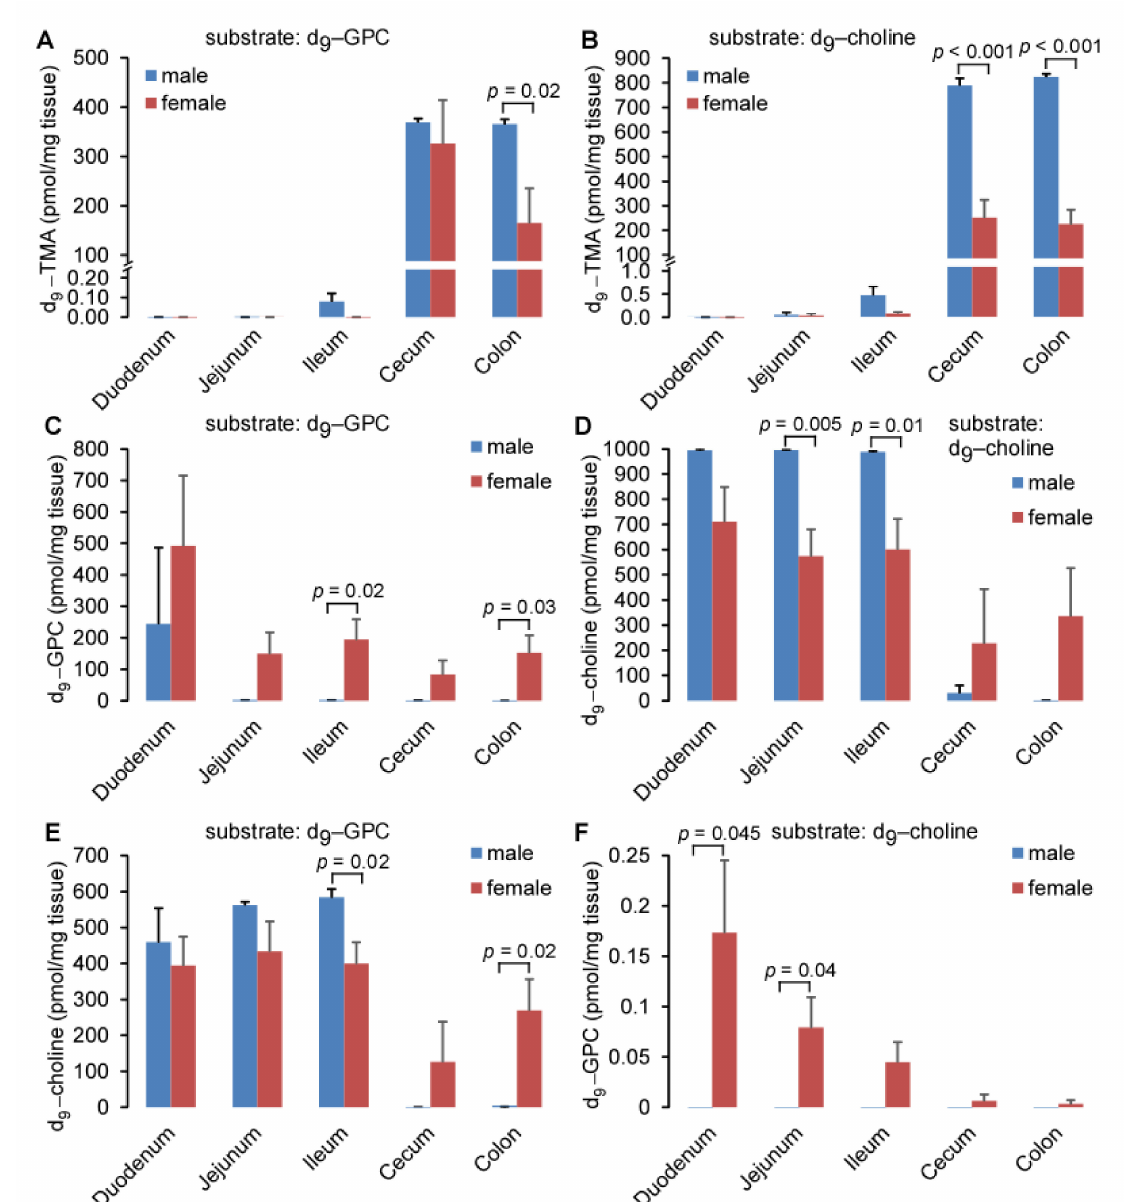
Figure 1. GPC can be efficiently metabolized to TMA and choline after incubation with intestinal segments. ( A , B ) d 9 -TMA, ( C , F ) d 9 -GPC, and ( D , E ) d 9 -choline content after intestinal segments were incubated with 20 volumes of 50 µ M d 9 -GPC ( A , C , E ) or d 9 -choline ( B , D , F ). Different intestinal segments were harvested from five female or three male C57/BL6J mice and incubated with d 9 -choline and d 9 -GPC under anaerobic conditions for 16 h. d 9 -TMA, d 9 -GPC, and d 9 -choline were quantified by LC-MS/MS, as described in Materials and Methods. Data are presented as mean ± SE from the indicated numbers of mice. p values were calculated by Student’s test, and only the values less than 0.05 are